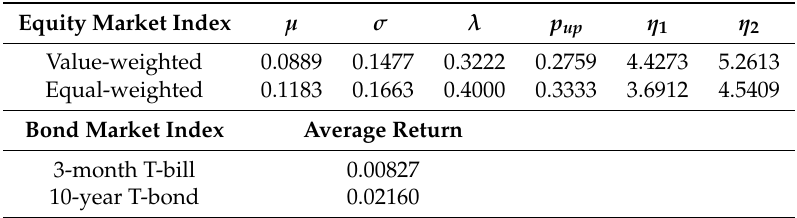
Table 1. Annualized parameter estimates based on real monthly data from 1926:1 to 2015:12. These values originally appeared in Forsyth and Vetzal (2019) and are reproduced here for convenience. Parameters for the equity market indexes were estimated using the threshold technique of Cont and Mancini (2011). The average returns for the bond indexes were calculated as log [ B ( T ) / B ( 0 )] / T , where B ( t ) denotes the index level at the time t . Equity Market Index µ σ λ p up η 1 η